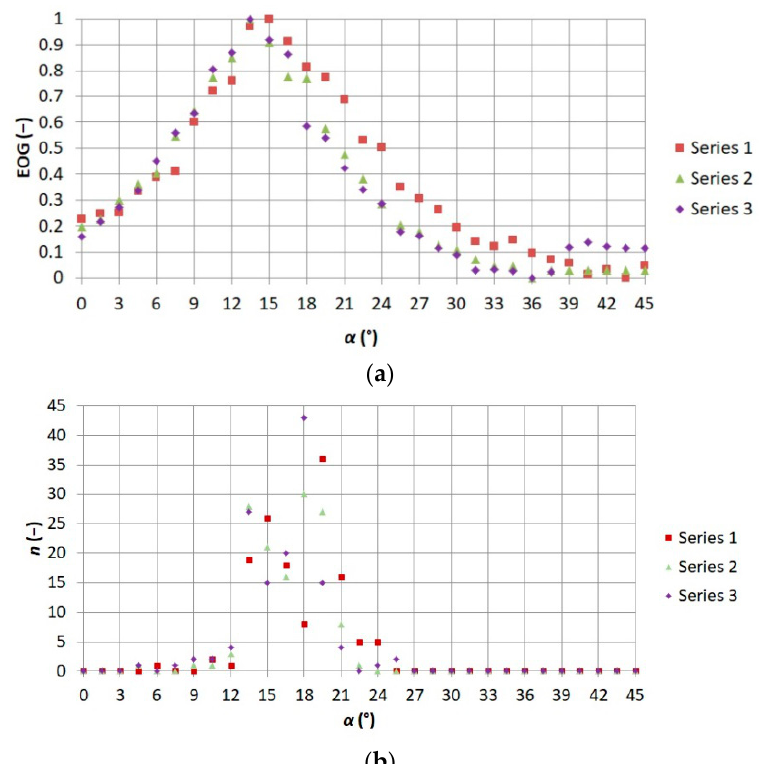
Figure 9. Comparison of relationship ( a ) between EOG (Energy of Gradient) measure of sharpness and the angle of focus adjustment ring placed on the thermographic camera lens α 1–3 and ( b ) between numbers of thermograms indicated by observers as sharp n and adjustment ring angle on the thermographic camera lens α [19].